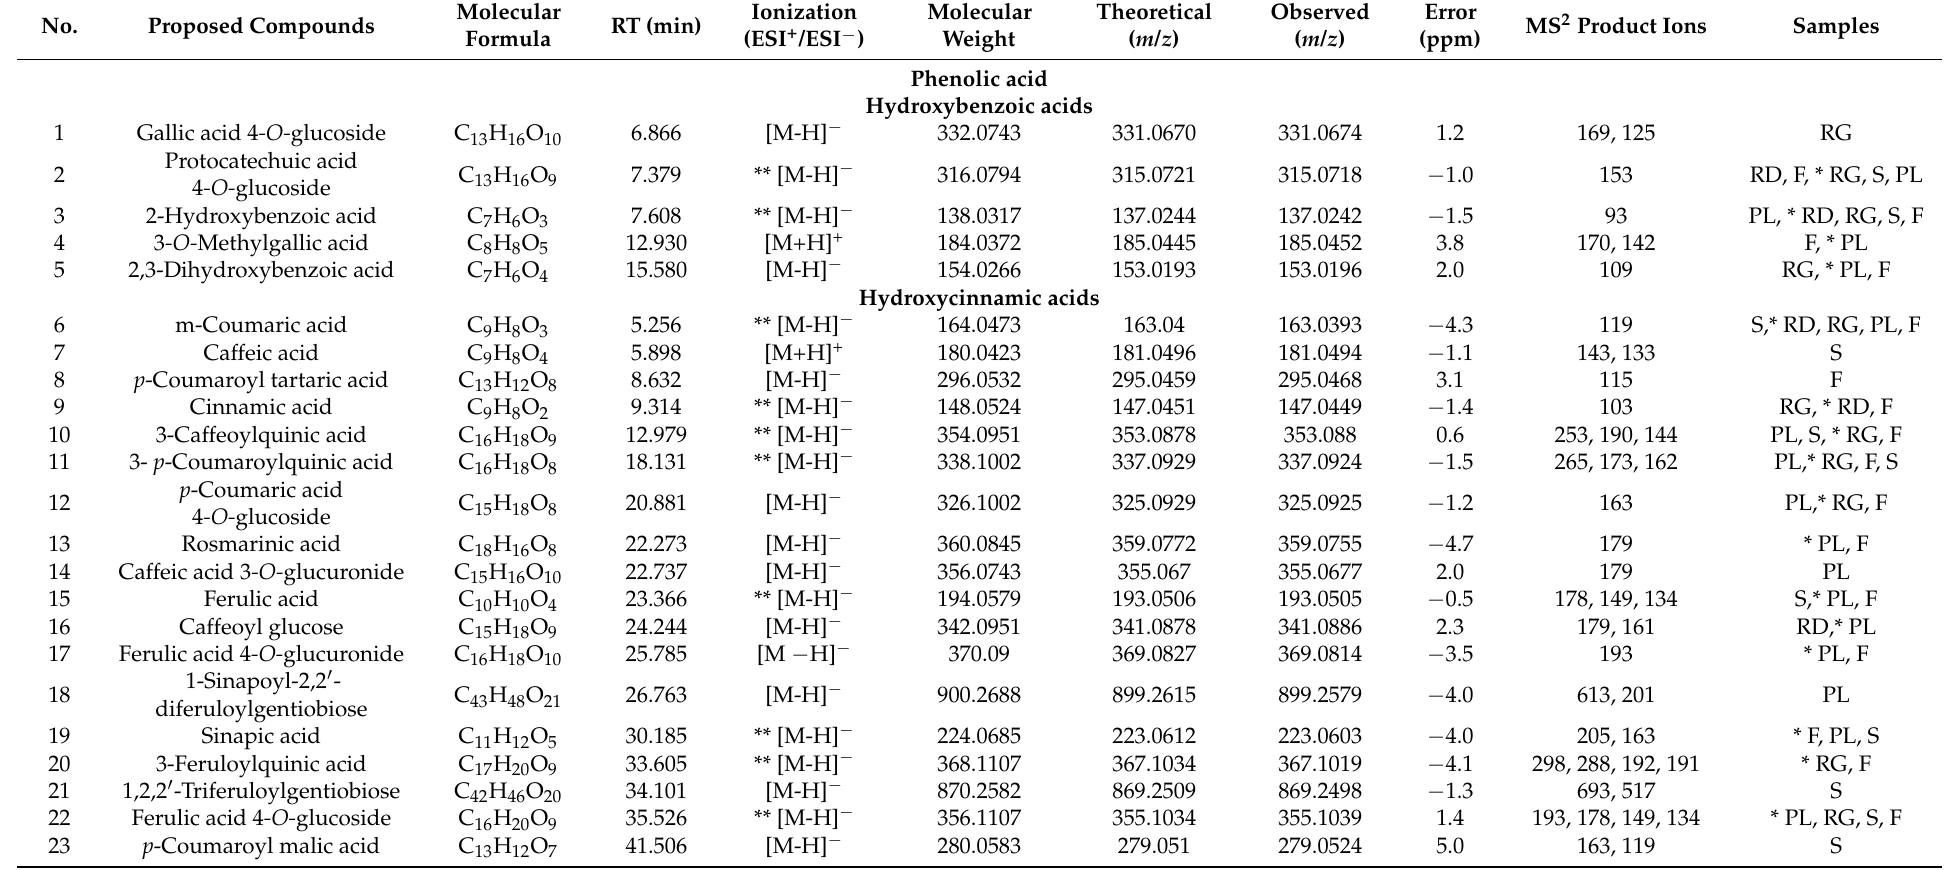
Table 3. Identification and characterisation of polyphenols in apples by using